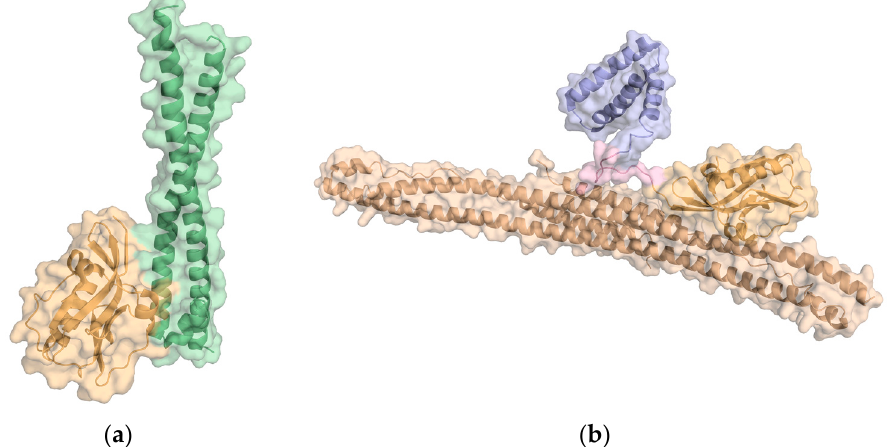
Figure 12. Cartoon representation of ( a ) crystal structure of the complex between ED-NS1 and p85 β subunit of PI3K (PDB ID: 6OX7); ( b ) crystal structure of the complex between NS1 and the coiled-coil domain of TRIM25 (PDB ID: 5NT2).